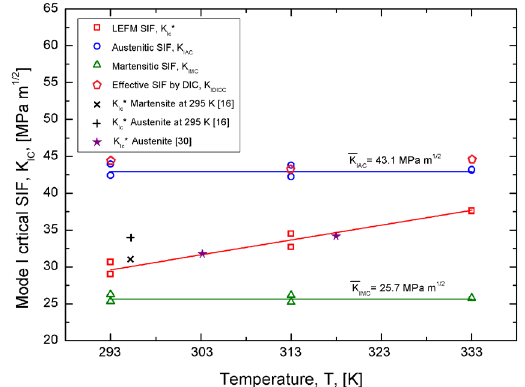
Figure 8. Critical values of the stress intensity factor as a function of the testing temperature: comparison between LEFM, analytical model and DIC